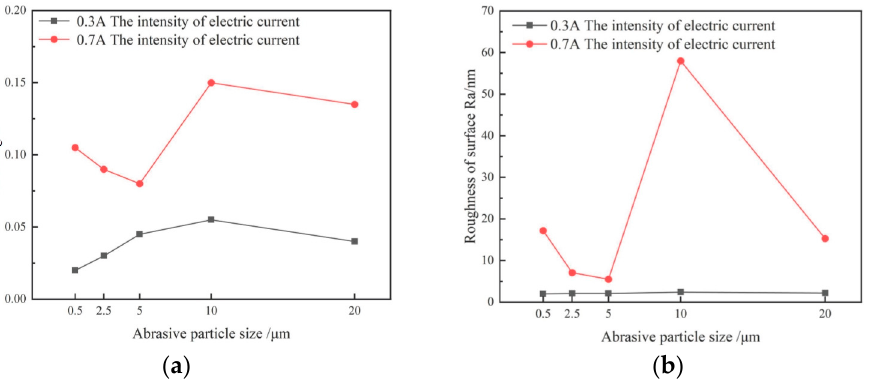
Figure 11. Curves of the material removal rate and roughness with the abrasive particle size. ( a ) Curve of material removal rate. ( b ) Curve of surface roughness.